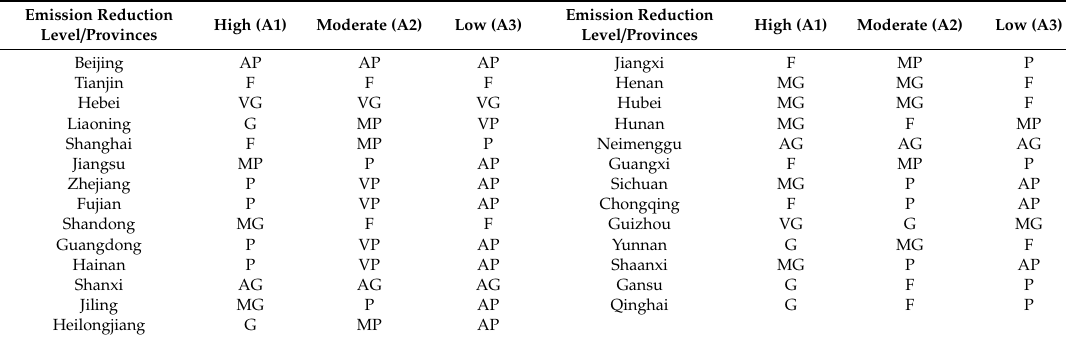
Table 1. Linguistic decision matrix for the di ff erent levels of emission reduction targets by the provinces in